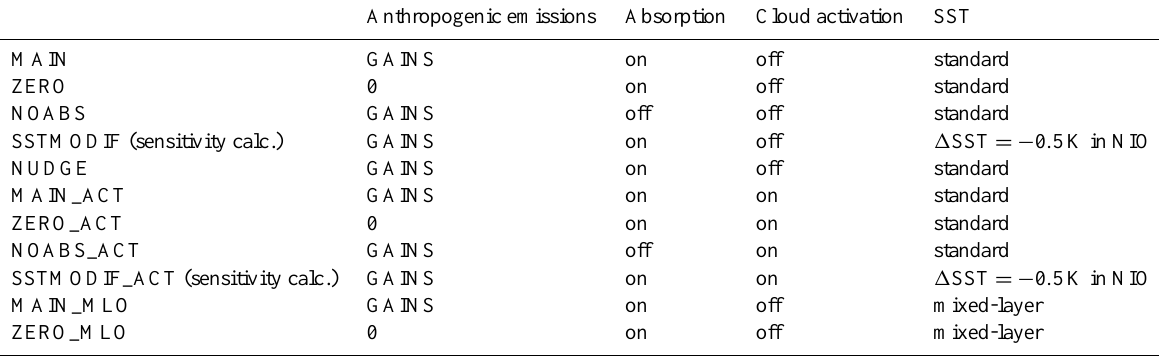
Table 1. The different simulations done, the anthropogenic emissions applied, aerosol light absorption (on/off), aerosol cloud activation (on/off) and SST field (standard: prescribed from coupled atmosphere–ocean model; see text). Anthropogenic emissions Absorption Cloud activation SST MAIN GAINS on off standard